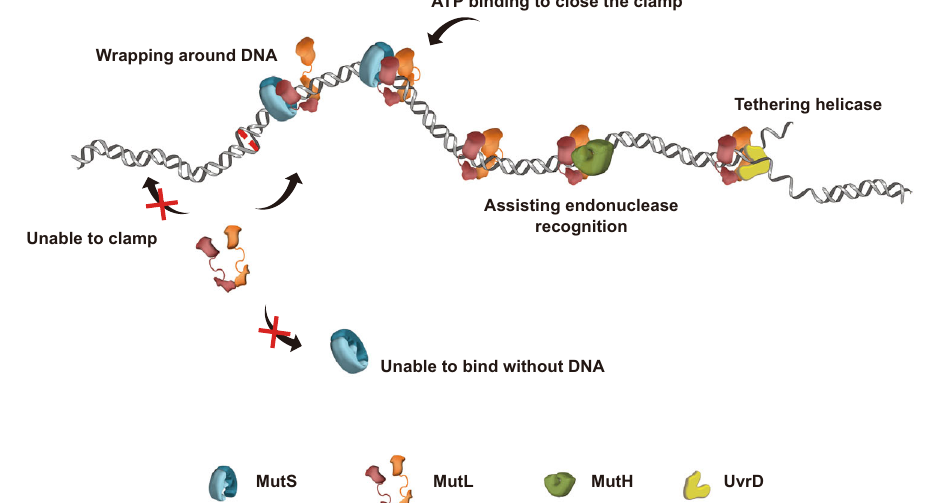
disordered linker connecting N- and C-terminal domains of MutL are drawn as curvylines. b Amodelofthecomplete E.coli MMRprocess.Seetextandref.20for detailed descriptions. Shape and color-coded MMR proteins are shown in key